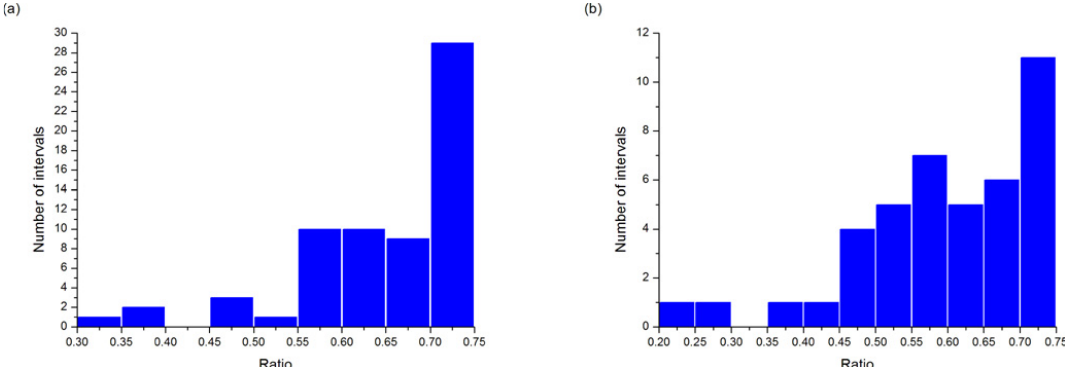
Fig. 7. The distribution of B min /B ratios. (a) For magnetic holes detected by Cluster with 0.2s resolution magnetic field data. (b) For TC-1 magnetic holes selected with spin resolution field data.